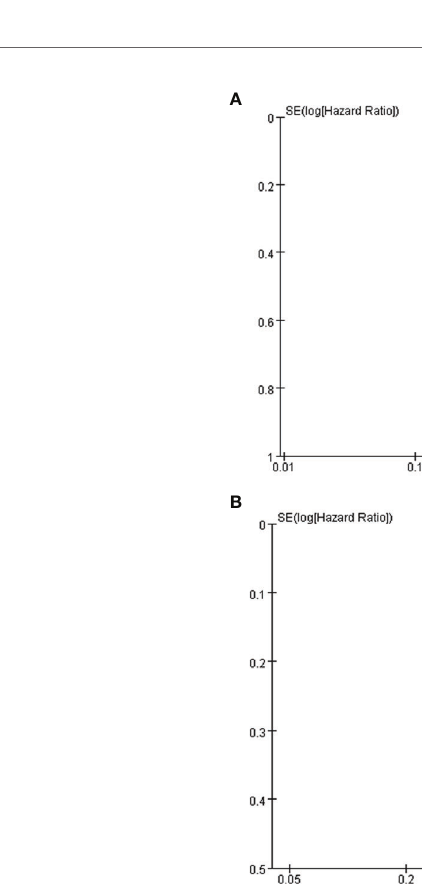
FIGURE 6 | Funnel plots for the publication bias underlying the meta-analyses; (A) funnel plots for the meta-analysis of OS; and (B) funnel plots for the meta- analysis of